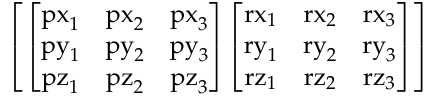
The structure of our convolutional layers includes a convolution layer with a ReLU ac- tivation and two dropout layers, followed by two fully connected layers. The convolutional layer has a filter size of 3 × 3 × 2 along the width and height; the stride in the horizon- tal and vertical directions is one. Our convolution is applied to the cells, and the same weights are applied to the position data in the first depth and orientation data in the second depth. This allows for treating position and orientation as a group and deriving features between joints. A zero-padding solution controls the shrinkage of the output dimension from each convolution layer, and we add zero-padding on the borders. The